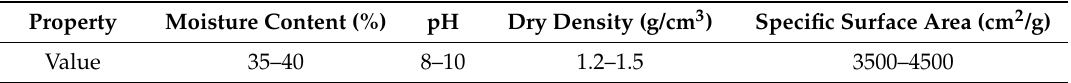
Table 1. Basic properties of boron waste.